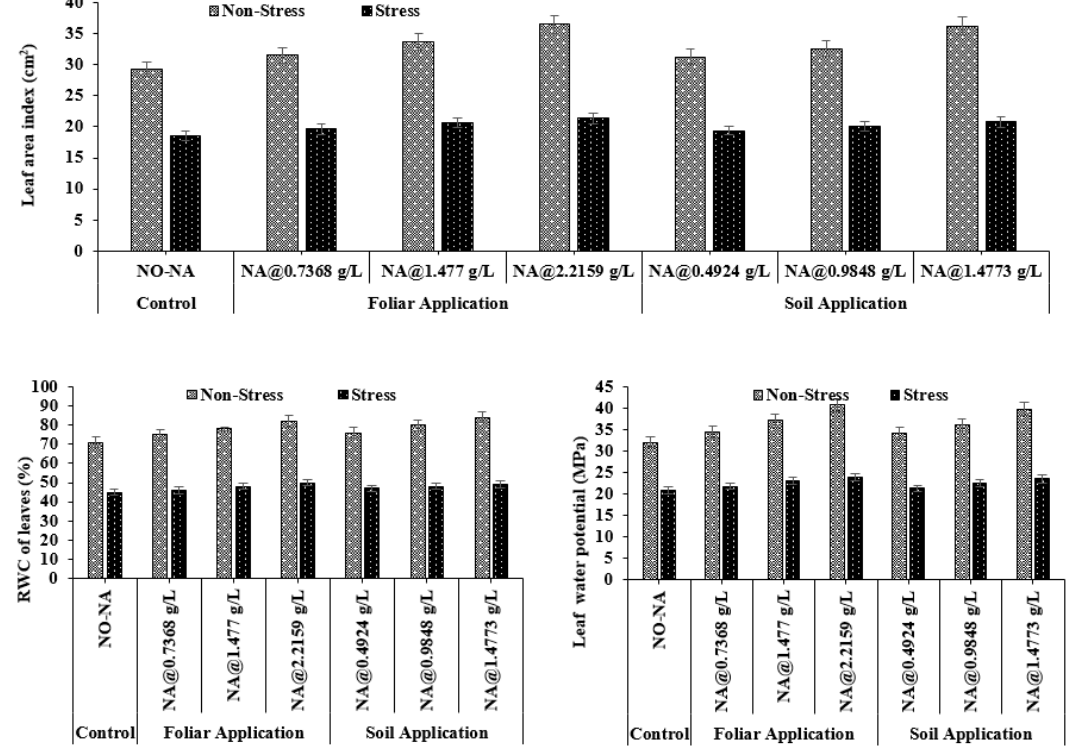
Figure 4. Effect of exogenously applied nicotinic acid on leaf area index (cm 2 ), the relative water content of leaves (%) and leaf water potential (MPa) at anthesis stage of plant under control and water deficit stress levels.